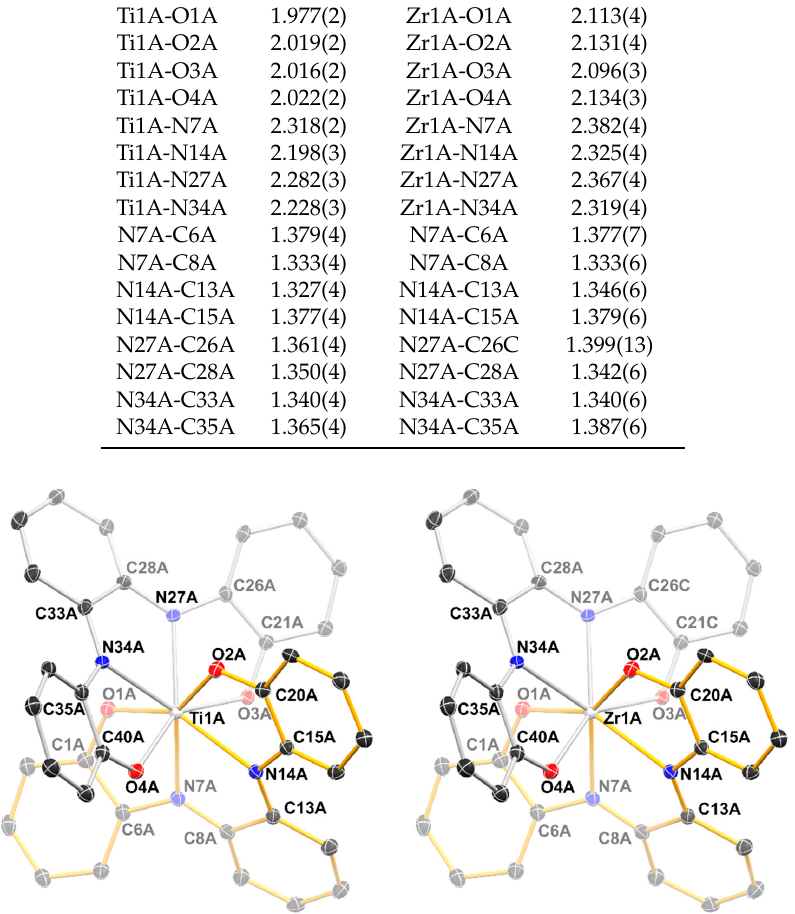
Figure 1. The crystal structures of [Ti(L ox ) 2 ] and [Zr(L ox ) 2 ]. The hydrogen atoms and tert -butyl groups are omitted for clarity. Thermal ellipsoids are drawn at the 30% probability level.